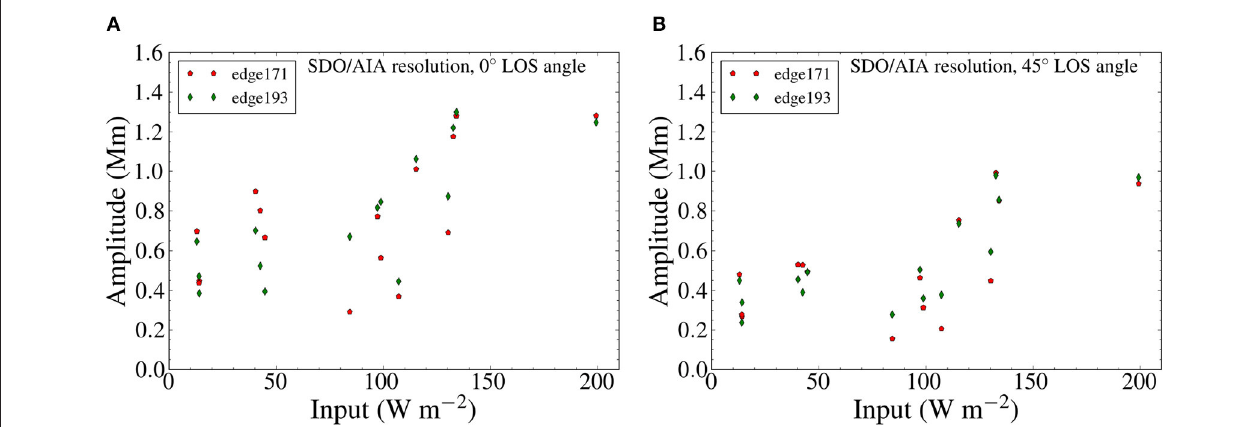
FIGURE 6 | Diagrams of the average oscillation amplitudes as a function of the average energy input for each model. In (A) we have a 0 ◦ LOS angle and in (B) we have a 45 ◦ LOS angle. Data from the Fe XII 193 Åline and the Fe IX 171 Åline were used. The loops displacements for the two lines were obtained by tracking their edge in the corresponding synthetic emission images.